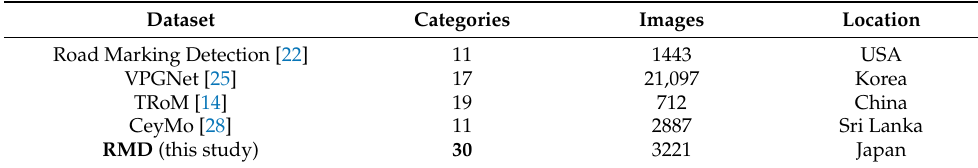
Table 1. Comparative statistics of the proposed RMD with the existing datasets.